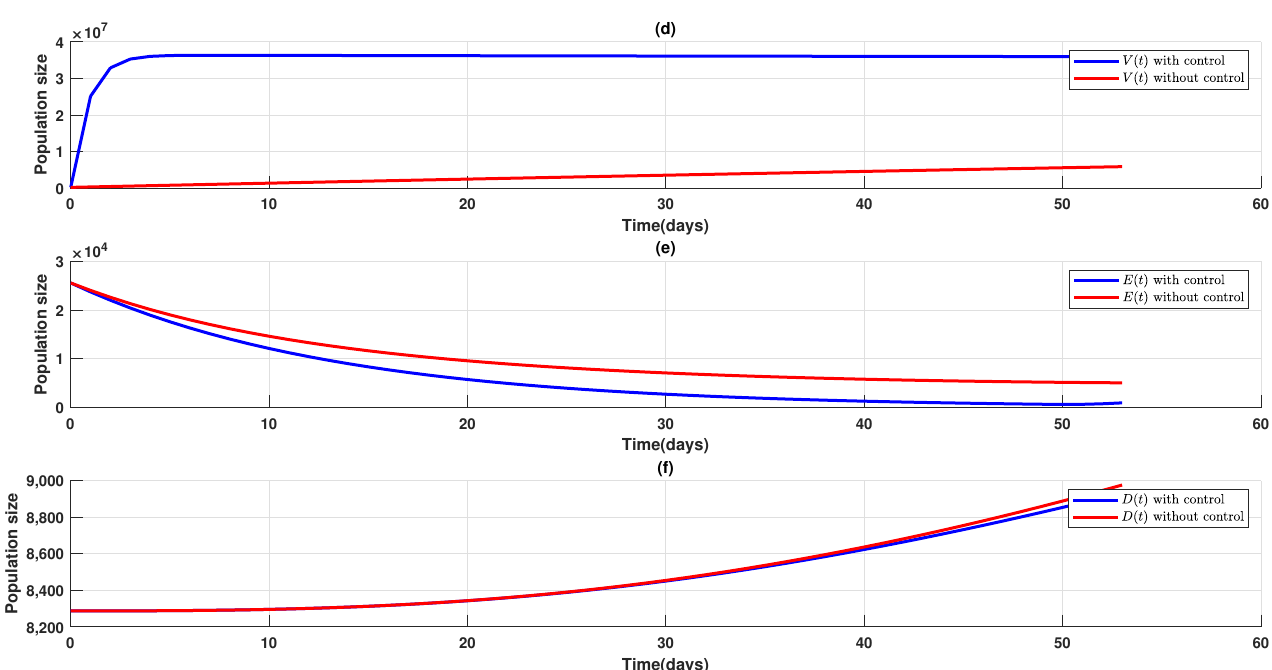
Figure 4. Time series of the states S, I and R without and with control.